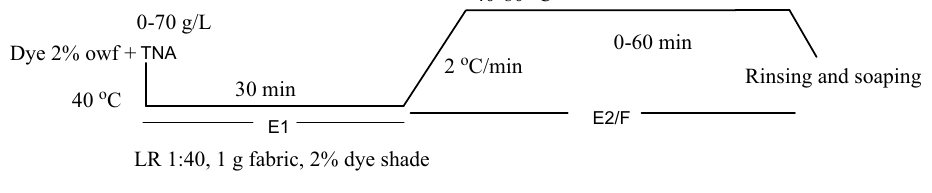
Figure 2. The dyeing profile of conventional and TNA